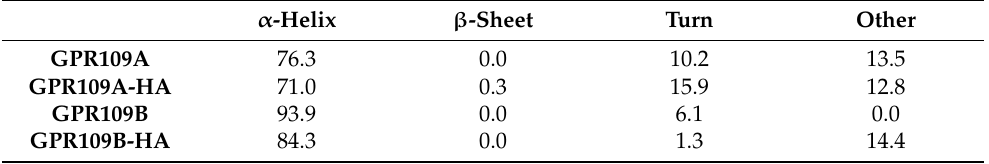
Table 6. Secondary structure contents (in %) of GPR109A and GPR109B with and without HA. α -Helix β